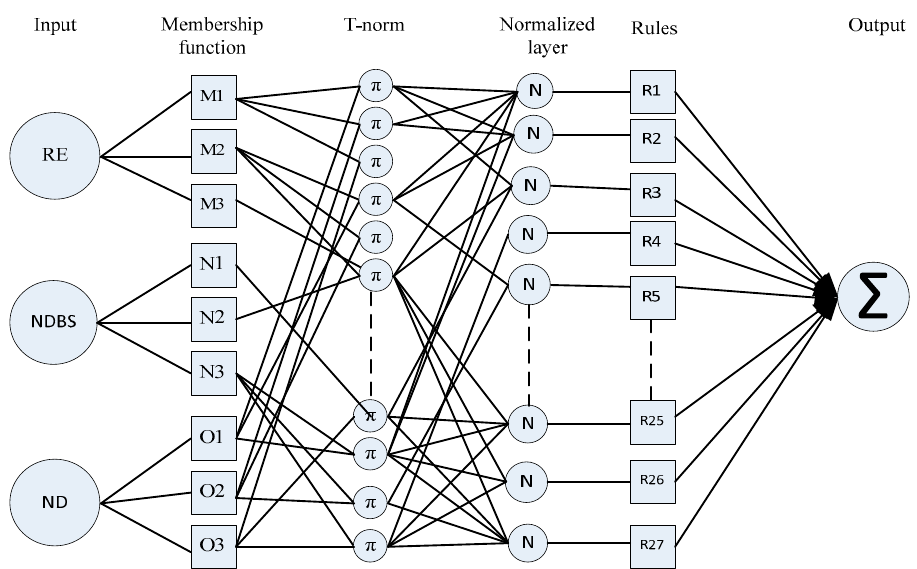
Figure 5. Three input type-3 adaptive neuro fuzzy inference system (ANFIS) with 27 rules and one output.